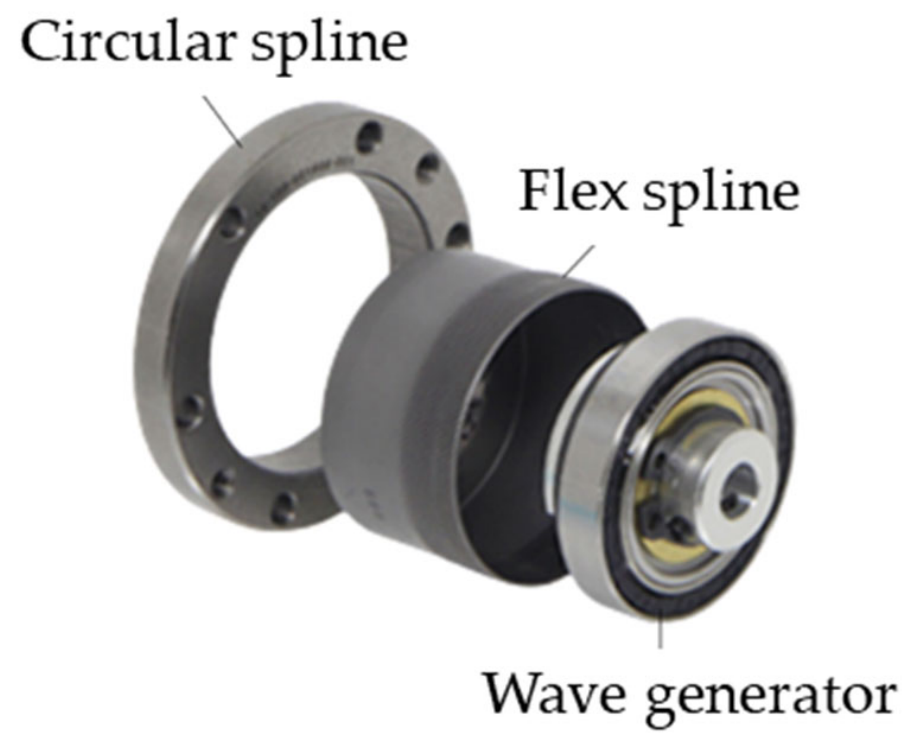
Figure 1. Harmonic Drive Components.